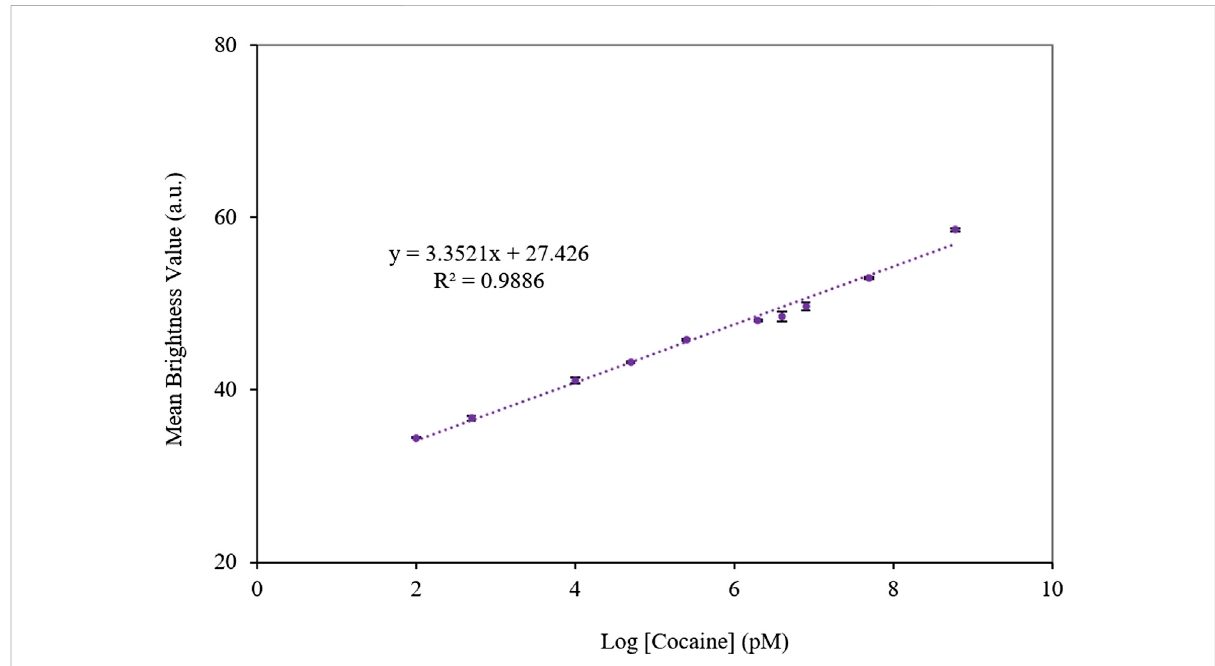
Thecalibrationcurveofthemeanbrightnessvalueandcocaineconcentrationbasedonthe fl uorescenceresponseoftheaptasensor.Theerror bars represent the average standard errors for three measurements.